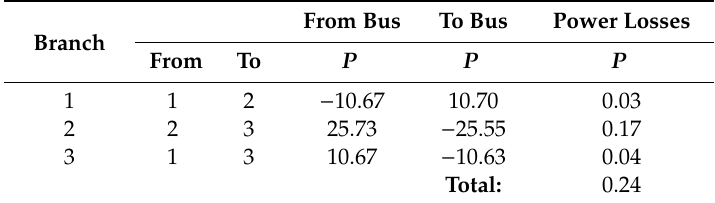
Table A11. Results of the mixed AC / DC PF calculations in Case 3. DC branch data.